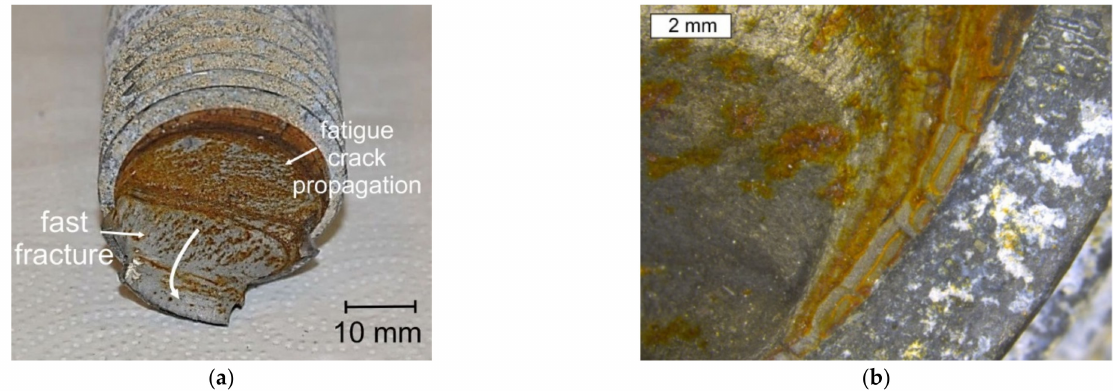
Figure 8. General view ( a ) and stereoscopic image ( b ) of the S6 bolt fracture. The elliptic wrapping of the beach